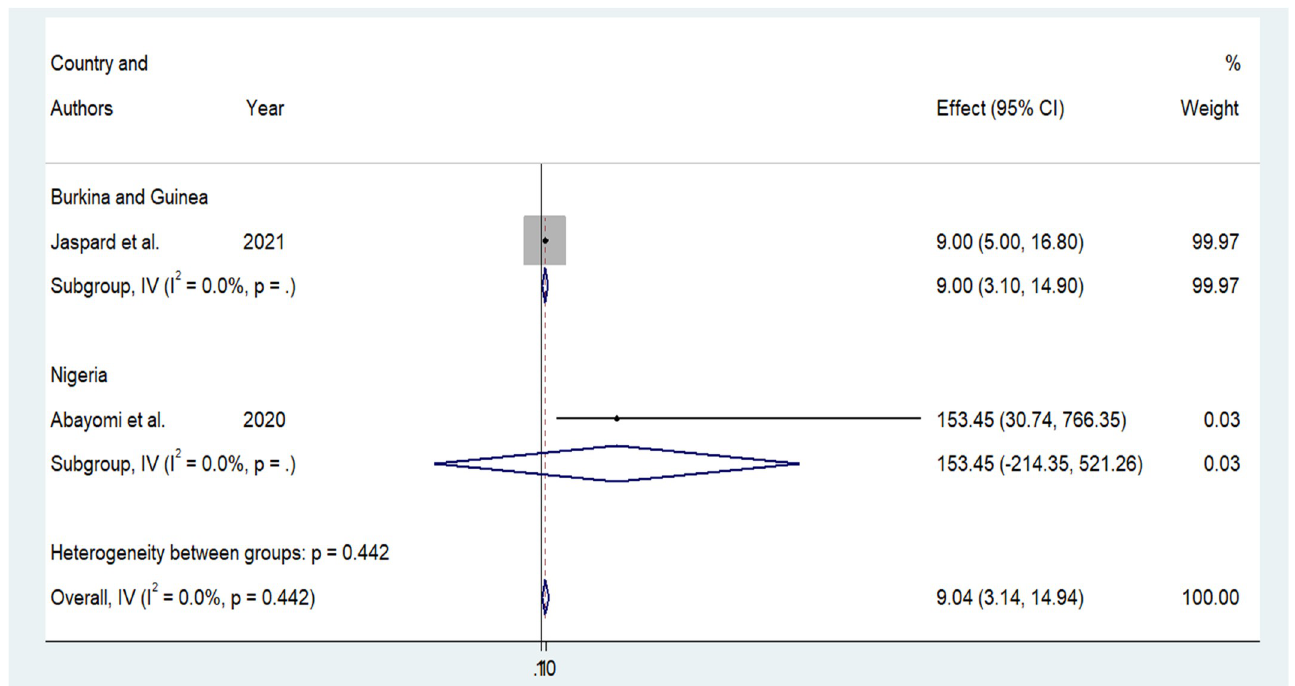
Fig 7. Forest plot showing the estimate for the effects of severe or critical on COVID-19 mortality.